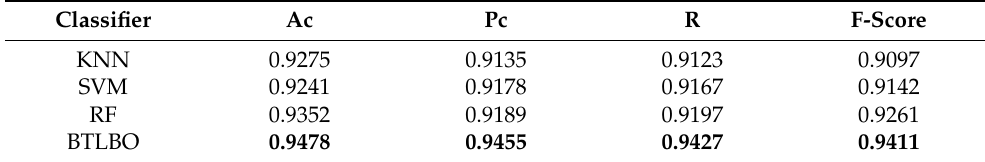
Table 12. The evaluation index of compared